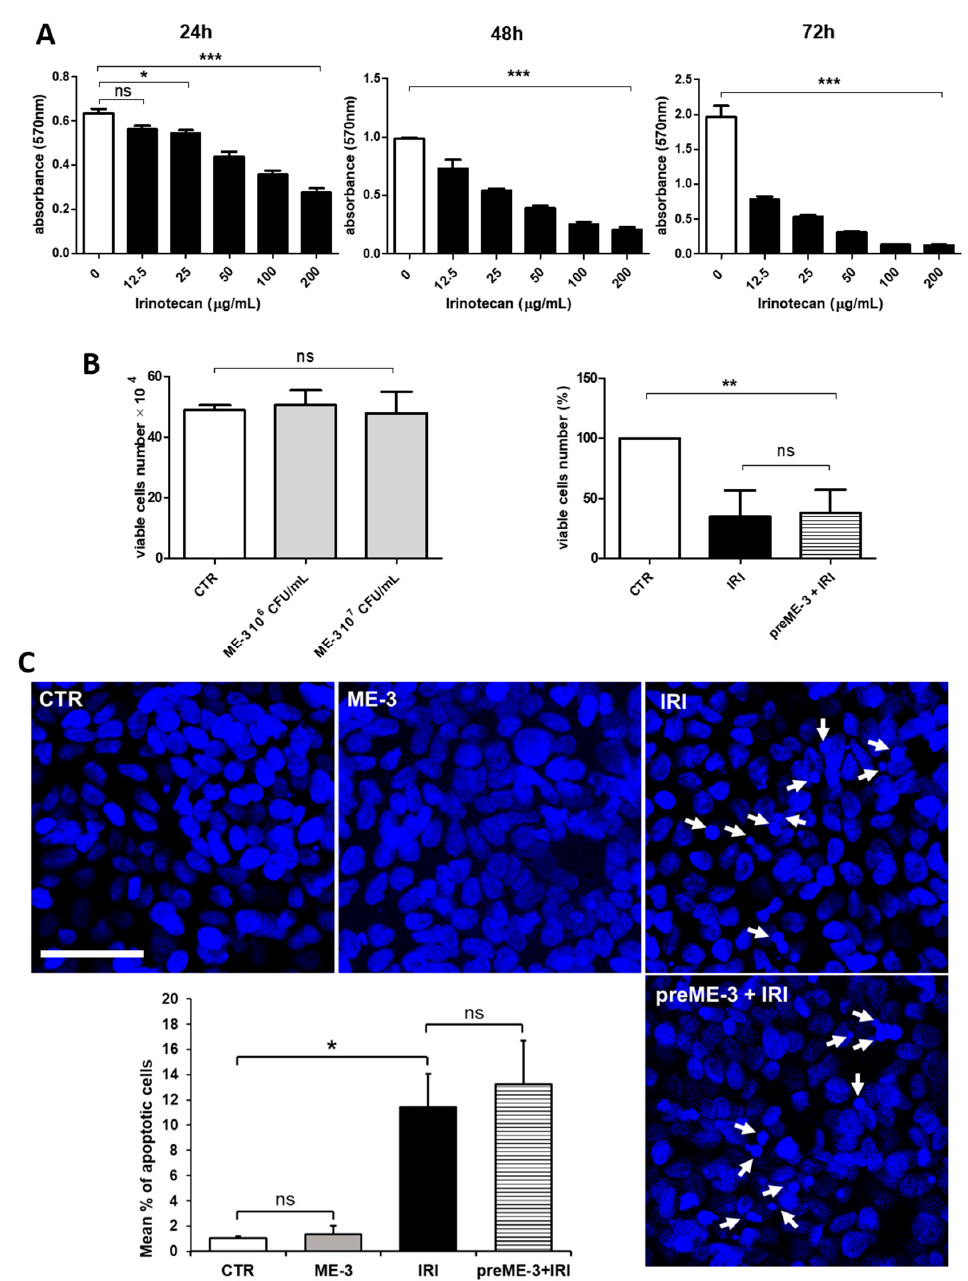
Figure 1. Effects of Irinotecan and ME-3 ® on the proliferation and vitality of Caco-2 cells. ( A ) Time course of the antiproliferative effect of IRI on the Caco-2 cell line. Cell proliferation was determined by MTT assay. The values are expressed as the means of three experiments ± SDs. ( B ) Viability of Caco-2 cells treated with two different concentrations of ME-3 ® for 24 h (left) or pretreated with ME- 3 ® (10 7 CFU/mL) for 24 h and then with IRI (155 µg/mL) for an additional 24 h (i.e., preME-3 ® + IRI) (right). Cell proliferation was determined by cell counts in trypan blue. Values are expressed as the means of three separate counts ± SDs. Asterisks in panels ( A , B ) represent significant differences between indicated groups: * p < 0.05, ** p < 0.01, *** p < 0.001; ns = not significant. ( C ) Representative images obtained by confocal laser scanning microscopy and quantitative analysis (bar graph) of the percentage of Caco-2 cells exhibiting fragmented and/or condensed nuclei indicative of apoptosis (white arrows) in controls (untreated and ME-3 ® treated cells) and in IRI-treated cultures grown in the presence or absence of ME-3 ® pretreatment. Bar = 50 µm. The quantitative analysis of apoptotic